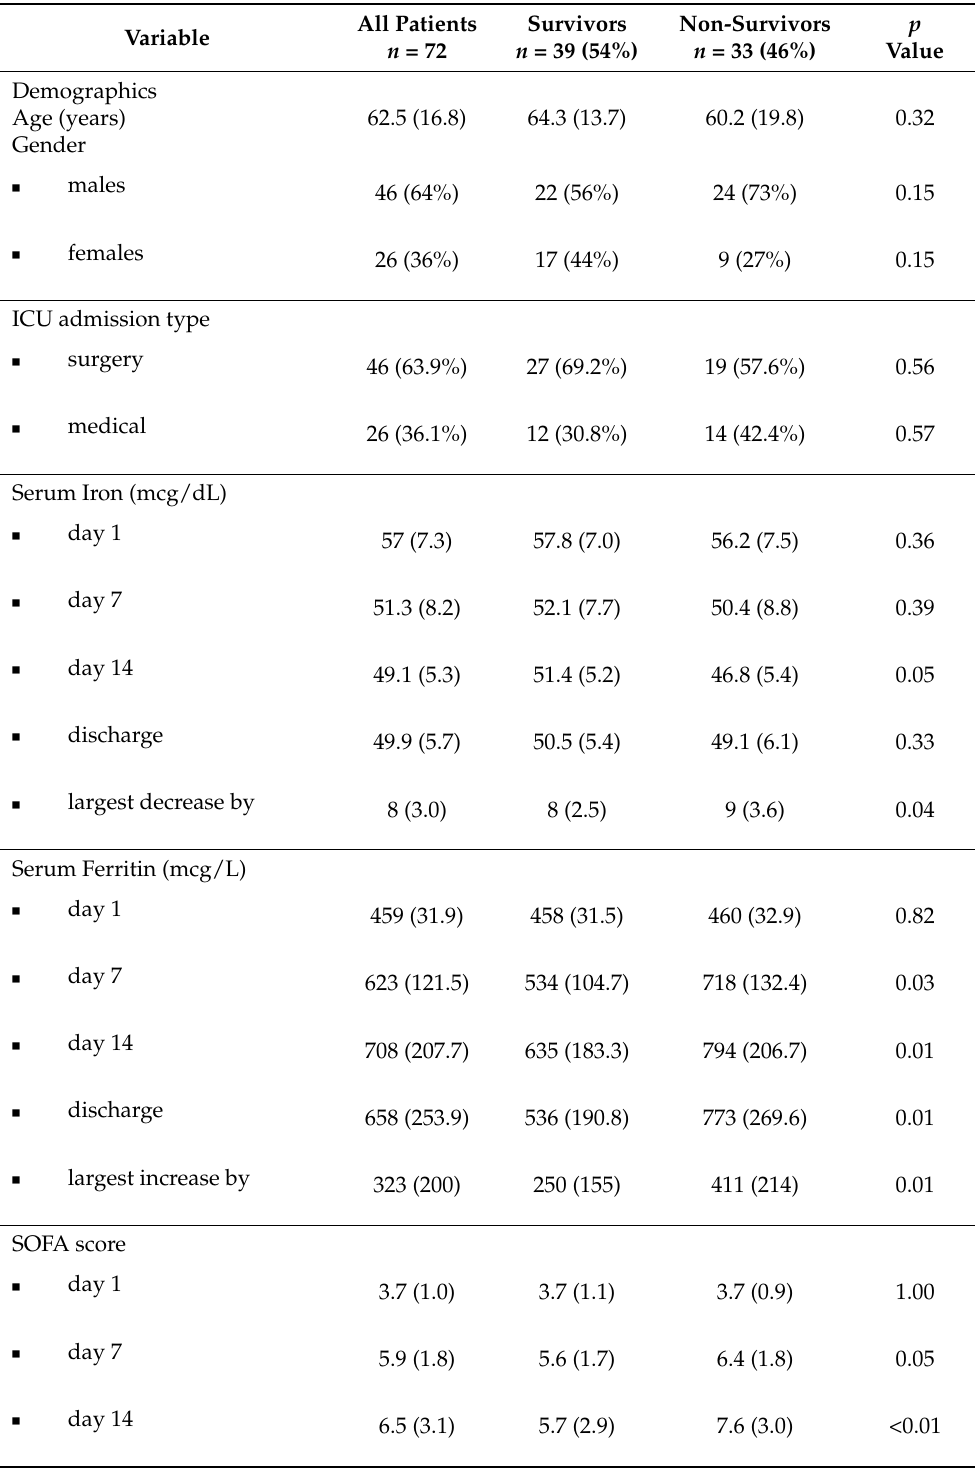
Table 1. Patients’ characteristics.